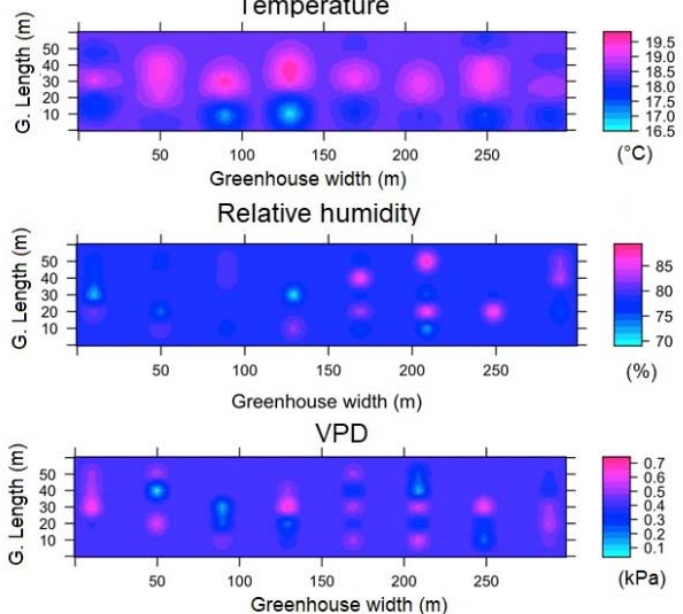
Figure A8. Spatial distribution predicted by kriging, for temperature, relative humidity and VPD in SG and for ESRL 3.